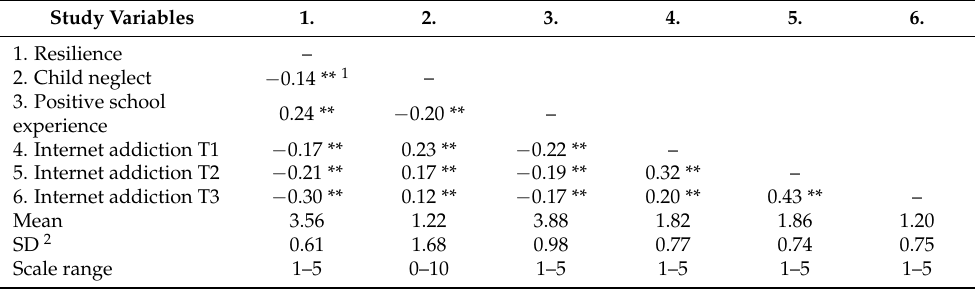
Table 1. Bivariate correlations, means, and standard deviations for study